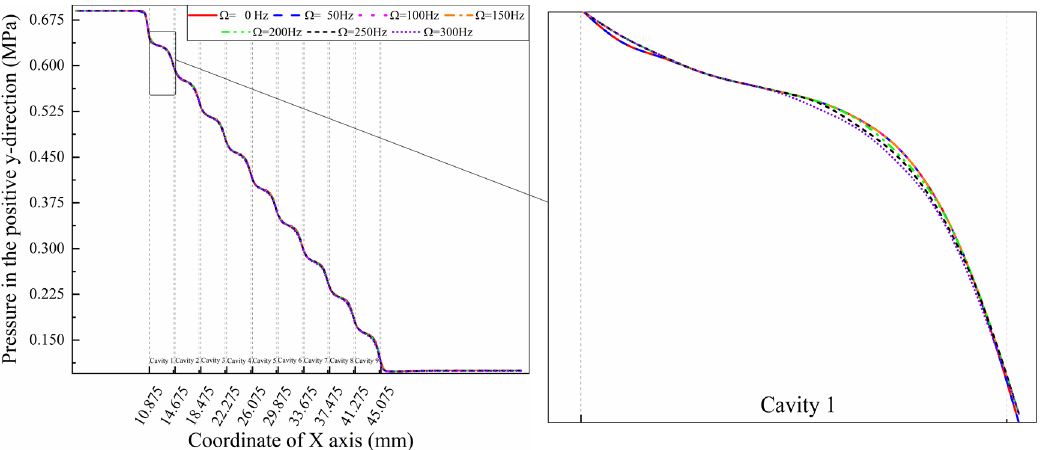
ω ω = 5000 rpm). = 5000 rpm).